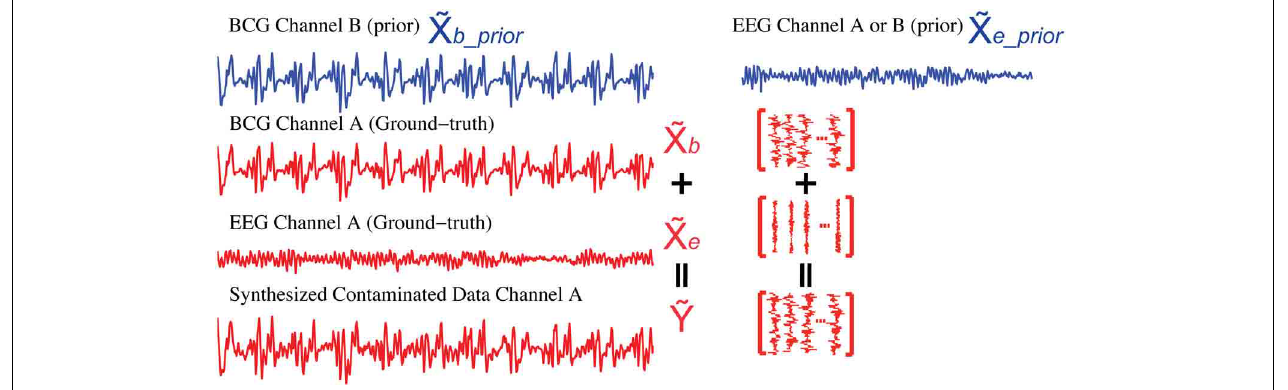
the prior EEG data ˜ X e _ prior . Simulated contaminated data ( ˜ Y ) is summed from the BCG ( ˜ X b ) and EEG ( ˜ X e ) data (red) both from channel A.